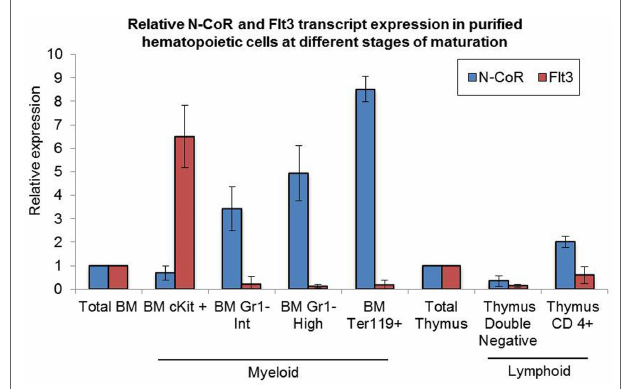
FigUre 1 | levels of n-cor and Flt3 transcripts in purified mouse hematopoietic cells . Levels of N-CoR and Flt3 transcripts in total bone marrow as well as in each purified subtypes of mouse hematopoietic cells were determined by real-time RT-PCR analysis. The values presented in the graph are average of three independent